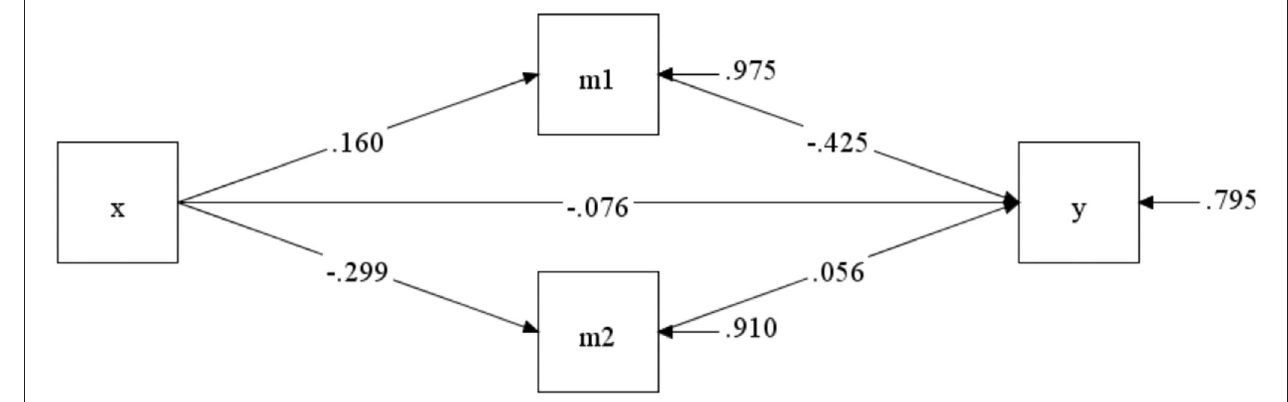
FIGURE 3 | The mediating model after 9-week intervention.